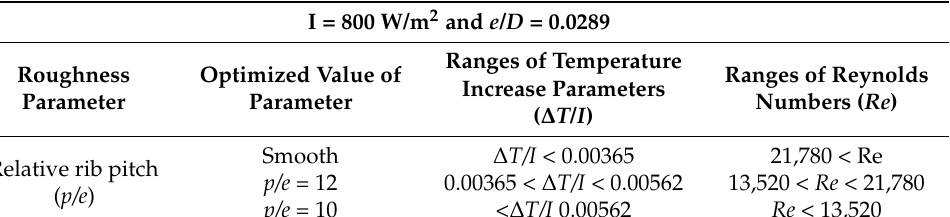
Figure 8. Effect of temperature increase parameter on effective efficiency.